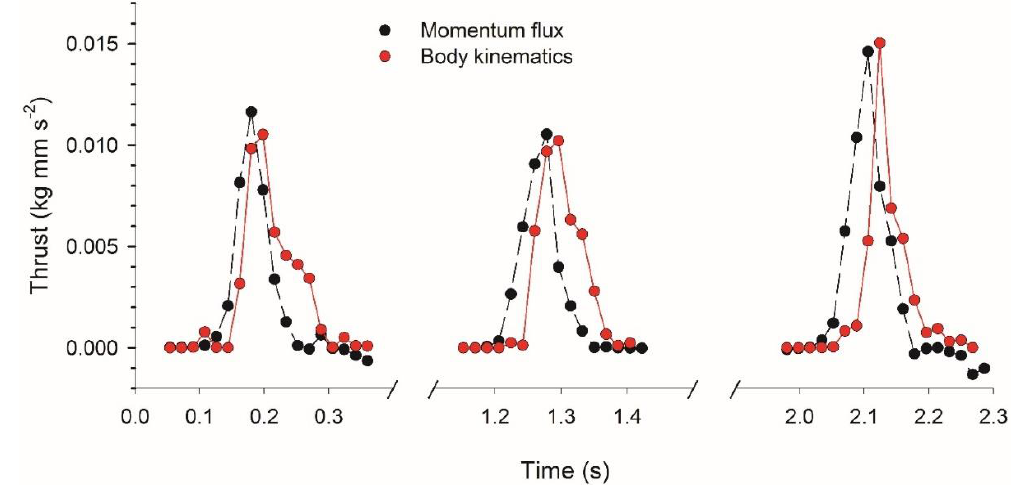
Figure 10. Comparison of thrust estimates based on momentum flux measurements in the near-body wake (e.g., Figure 4) with estimates based solely on body kinematics (subumbrellar volume changes) and fluid jet velocities. The latter approach is similar to that of Daniel (Ref. [4], for estimating thrust by a jet propelled medusa. Note that both methods yield relatively similar results, with a time lag due to temporal differences in body and flow kinematics.